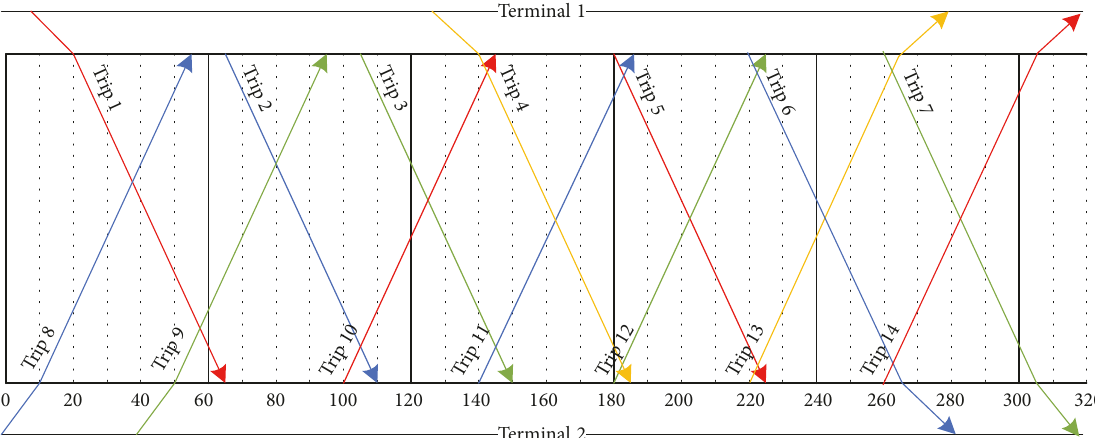
Figure 2: The modified timetable and the corresponding vehicle schedule